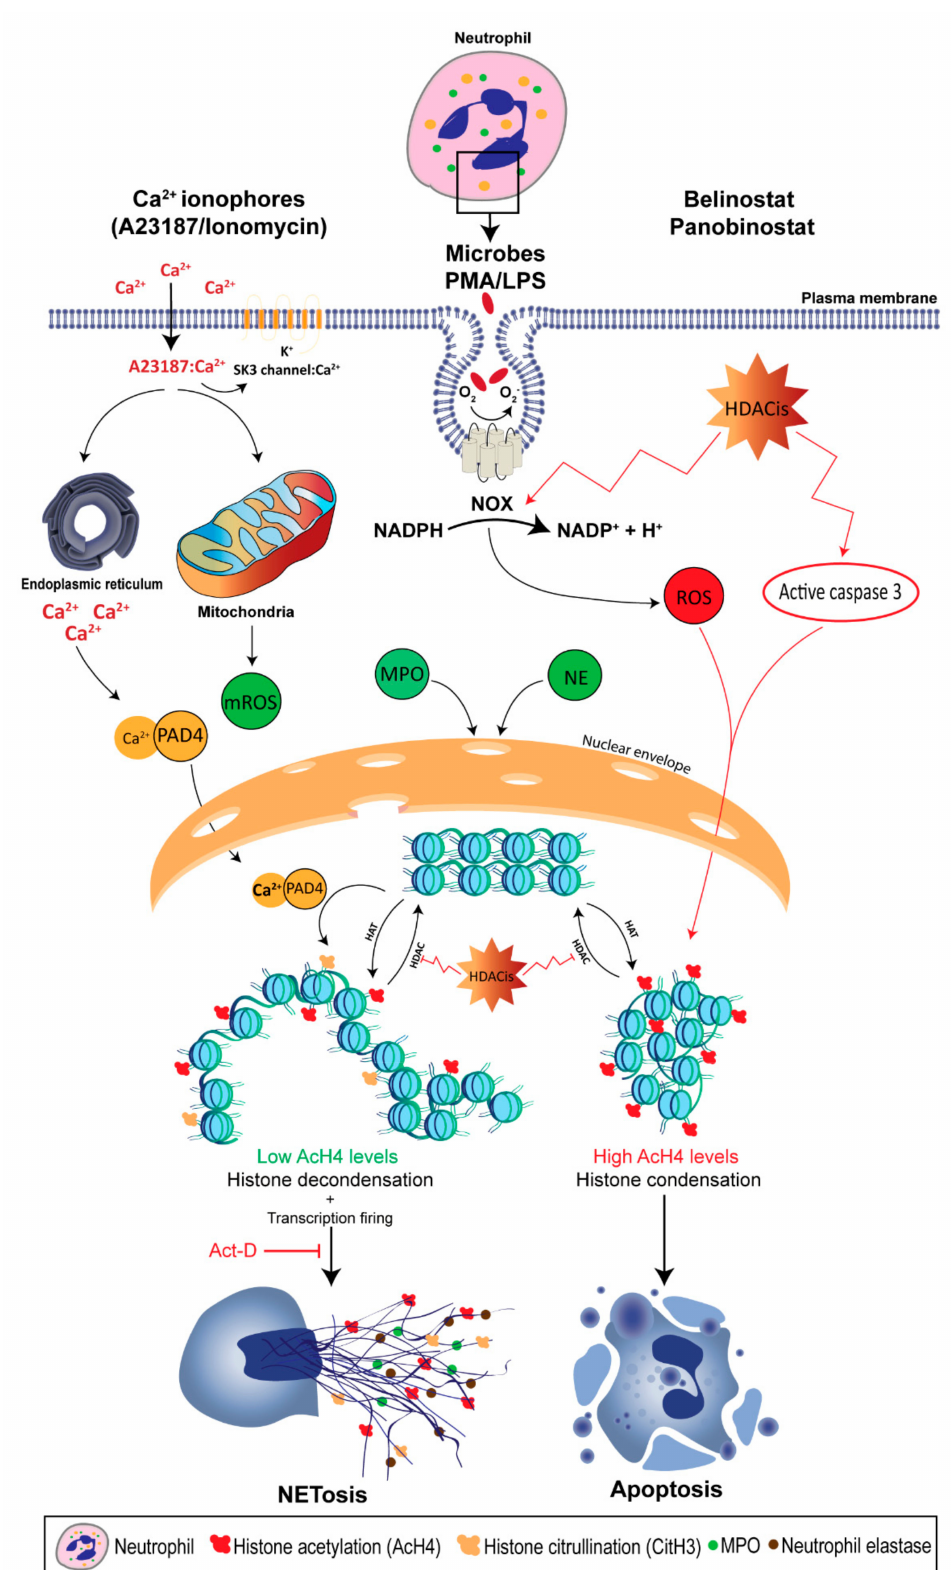
Figure 1. Citrullination (deimination) and acetylation in regulating neutrophil extracellular trap (NET) formation. Neutrophils can be activated during infection and inflammation to undergo NETosis. Calcium ionophores, such as A23187 and ionomycin, activate the NADPH oxidase (NOX)-independent, whereas phorbol myristate acetate (PMA) and lipopolysaccharide (LPS) induce NOX-dependent pathways of NETosis. Both pathways require increased levels of the reactive oxygen species (ROS)